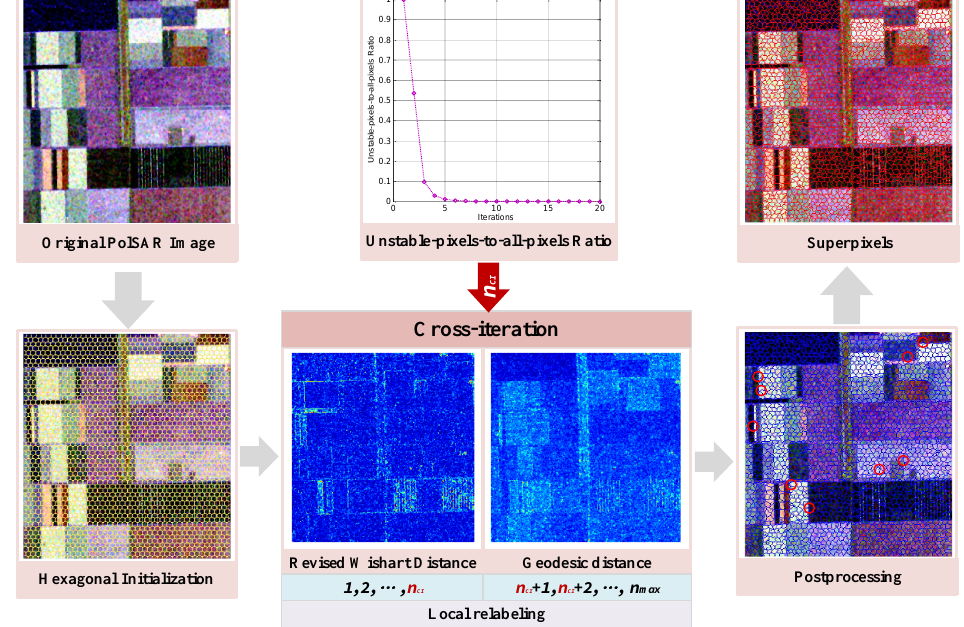
Figure 1. An overview of the proposed